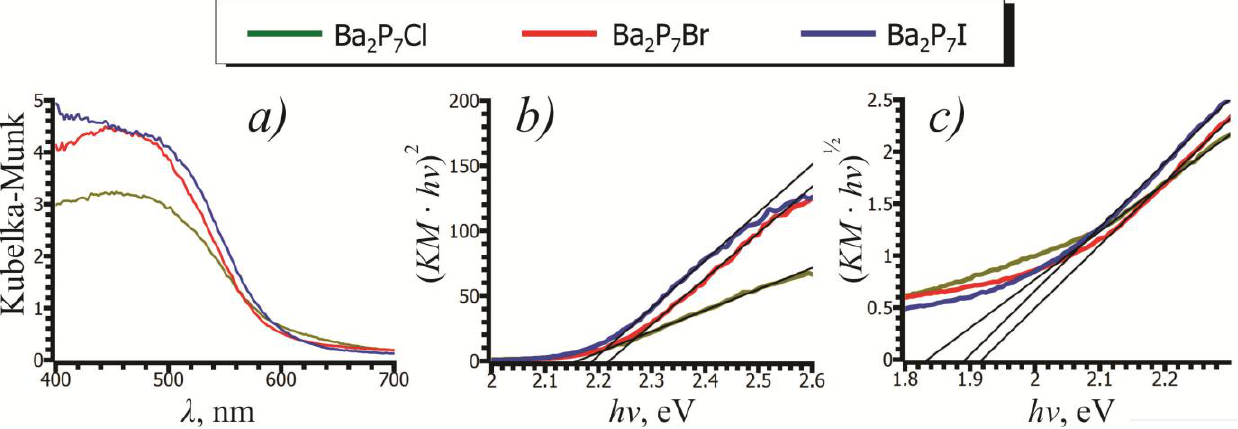
P X (X = Cl, Br, I) compounds. 2 7